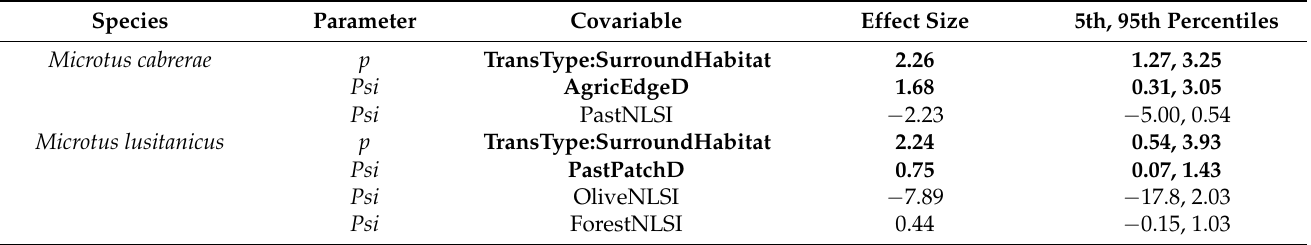
Table 5. Estimates of main effects (mean and 5th and 95th percentiles) on p and Psi obtained from the best model identified for Microtus cabrerae , and from model averaging of best models identified for Microtus lusitanicus . Variables with 5th and 95th percentile ranges not including 0 are shown in bold. Species Parameter Covariable Effect Size 5th, 95th Percentiles Microtus